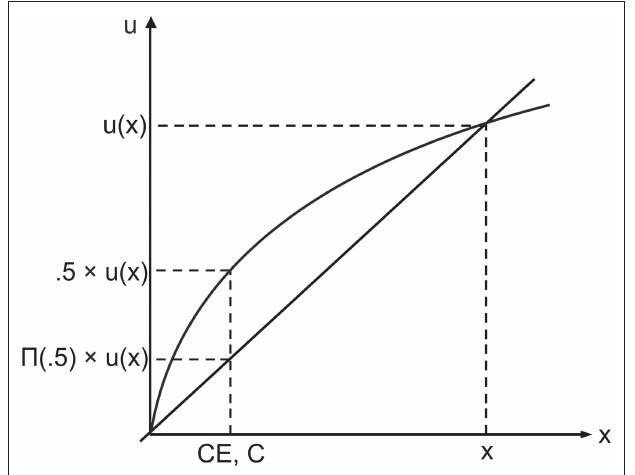
FIGURE 2 | Theoretical procedure how to determine a utility function if probabilities are perceived